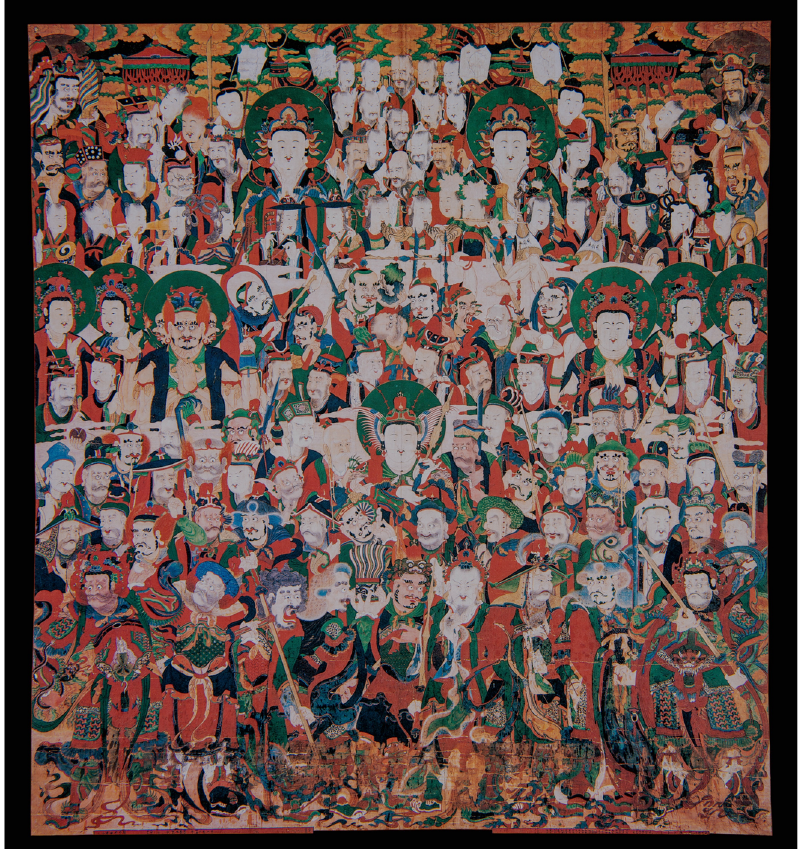
Figure 1. T ŏ gun et al. 124 Guardian Deities , 1862, Chos ŏ n dynasty (1392–1910). Colors on silk, 348 × Figure 1. Tŏgun et al. 124 Guardian Deities , 1862, Chosŏn dynasty (1392–1910). Colors on silk, 315.5 cm. Haein Monastery, Ky ŏ ngsang Province. Reproduced with permission from the Research 348 × 315.5 cm. Haein Monastery, Kyŏngsang Province. Reproduced with permission from the Re‑ Institute of Sungbo Cultural Heritage, Seoul. search Institute of Sungbo Cultural Heritage,